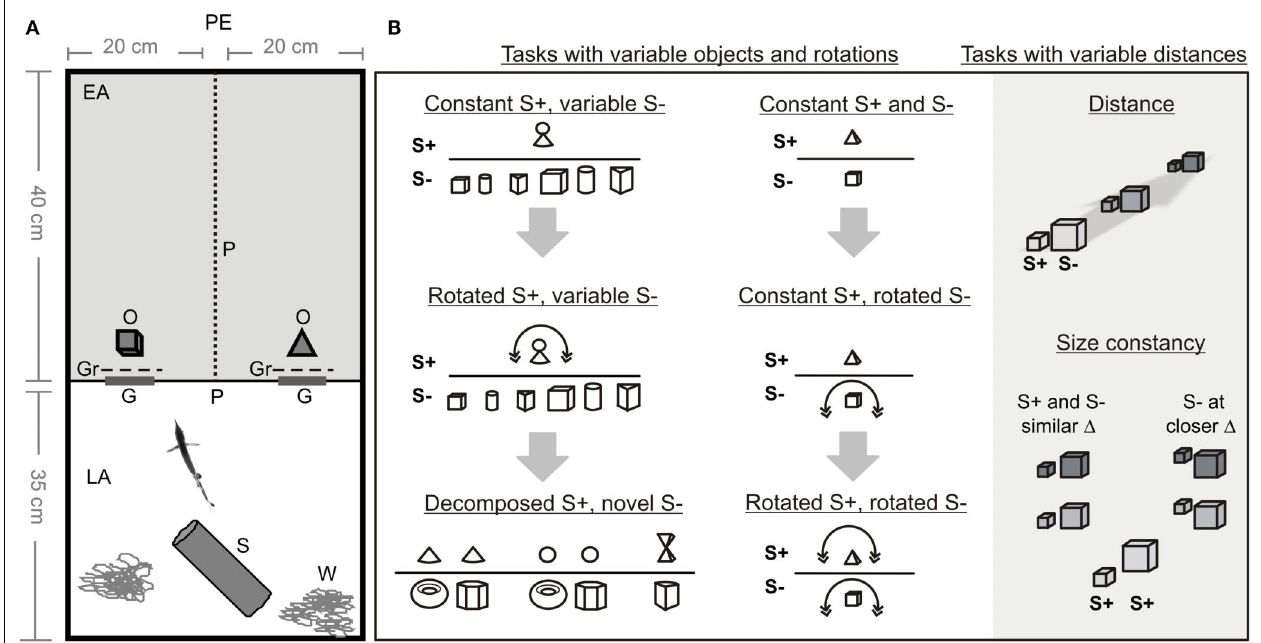
FIGURE 1 | (A) Experimental setup: PE, position of the experimenter; EA, experimental area; LA, living area; P, mesh partition; O, objects; Gr, grids; G, gates; S, shelter; W, water plants. (B) Schematic list of tasks. Different fi sh were